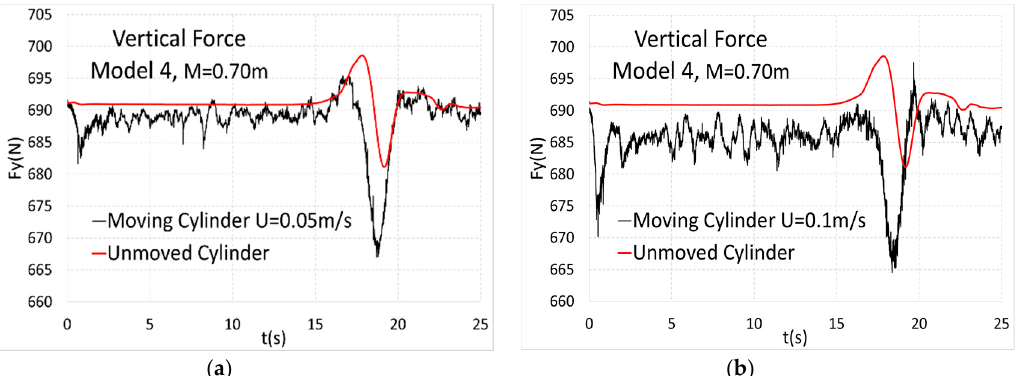
Figure 17. The time variation of vertical forces for model 4. ( a ) The comparison between the unmoved cylinder (red line) and the moving cylinder at U c = 0.05 m/s. ( b ) The comparison between the unmoved cylinder (red line) and the moving cylinder at U c = 0.1 m/s.